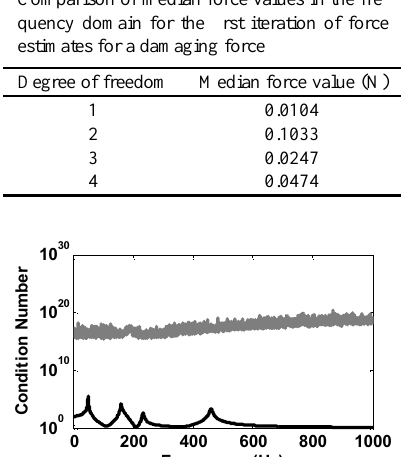
Table 2 Comparison of median force values in the fre-